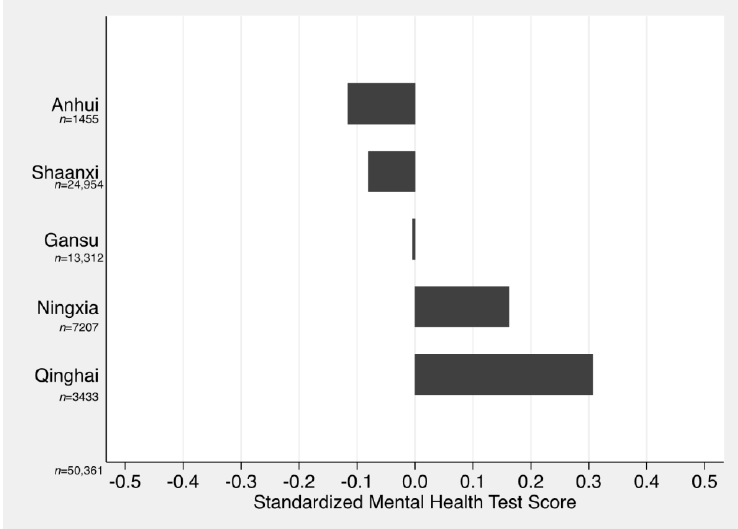
Figure 2. The distribution of standardized Mental Health Test (MHT) scores across provinces. Source: Authors’ data. Notes: The difference in standardized MHT scores between students in Qinghai and Anhui is 0.42 ( P = 0.00). Lower MHT scores indicate better mental health.